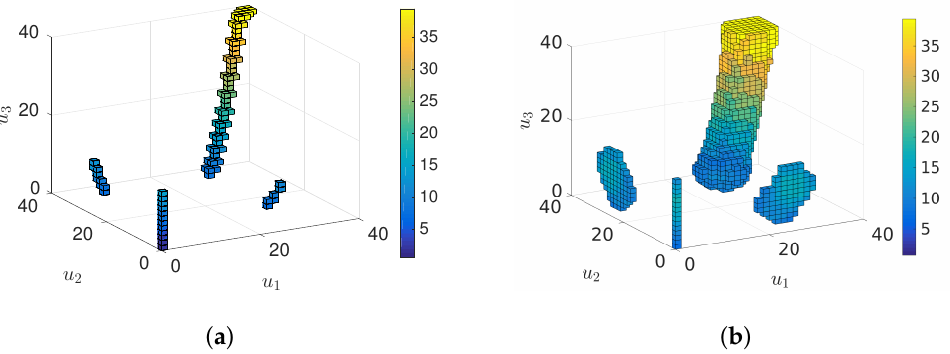
Figure 3. Example for an Multiobjective Optimization Problem (MOP) from production [32] where shown in ( a ), and the inexact set P S , (cid:101) is shown in ( b